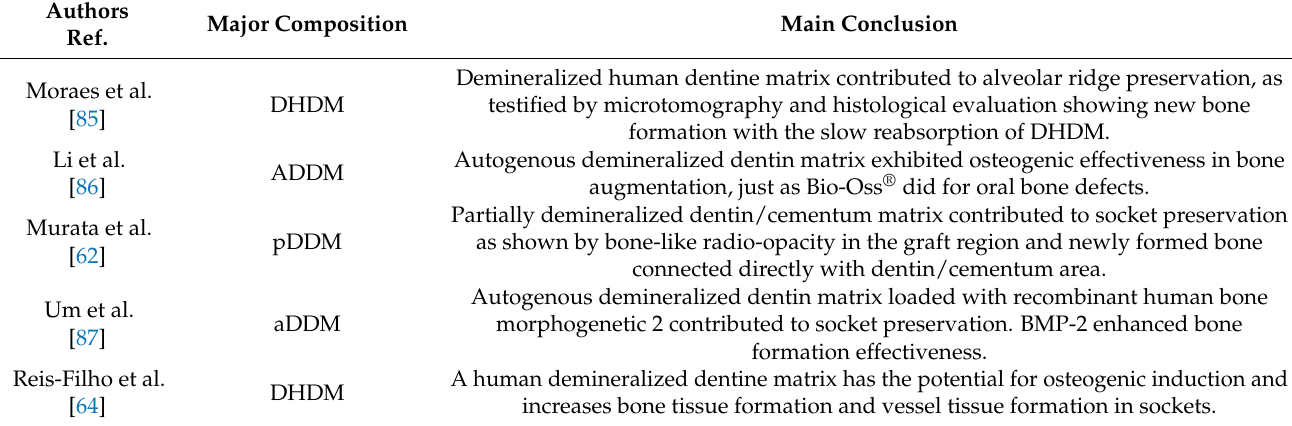
Table 7. Treated dentin matrix and its derivatives for bone